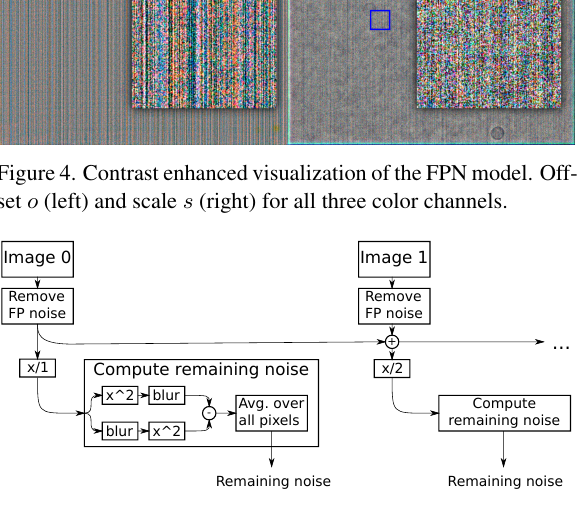
Figure 5. Evaluation of the noise reduction for varying numbers of images by iteratively averaging images and computing the av- erage local variance as an estimate of the remaining noise.